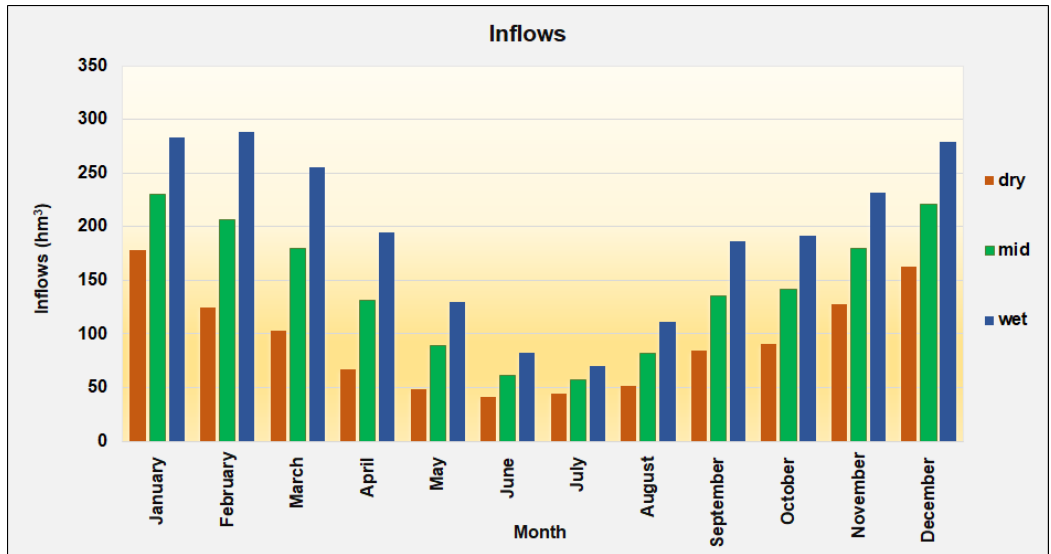
Figure 3. Monthly inflows of the Aliakmon’s River multi-reservoir system for the dry, mid and wet hydrological scenario. Table 3. Calculation of inflows for the three hydrological scenarios.